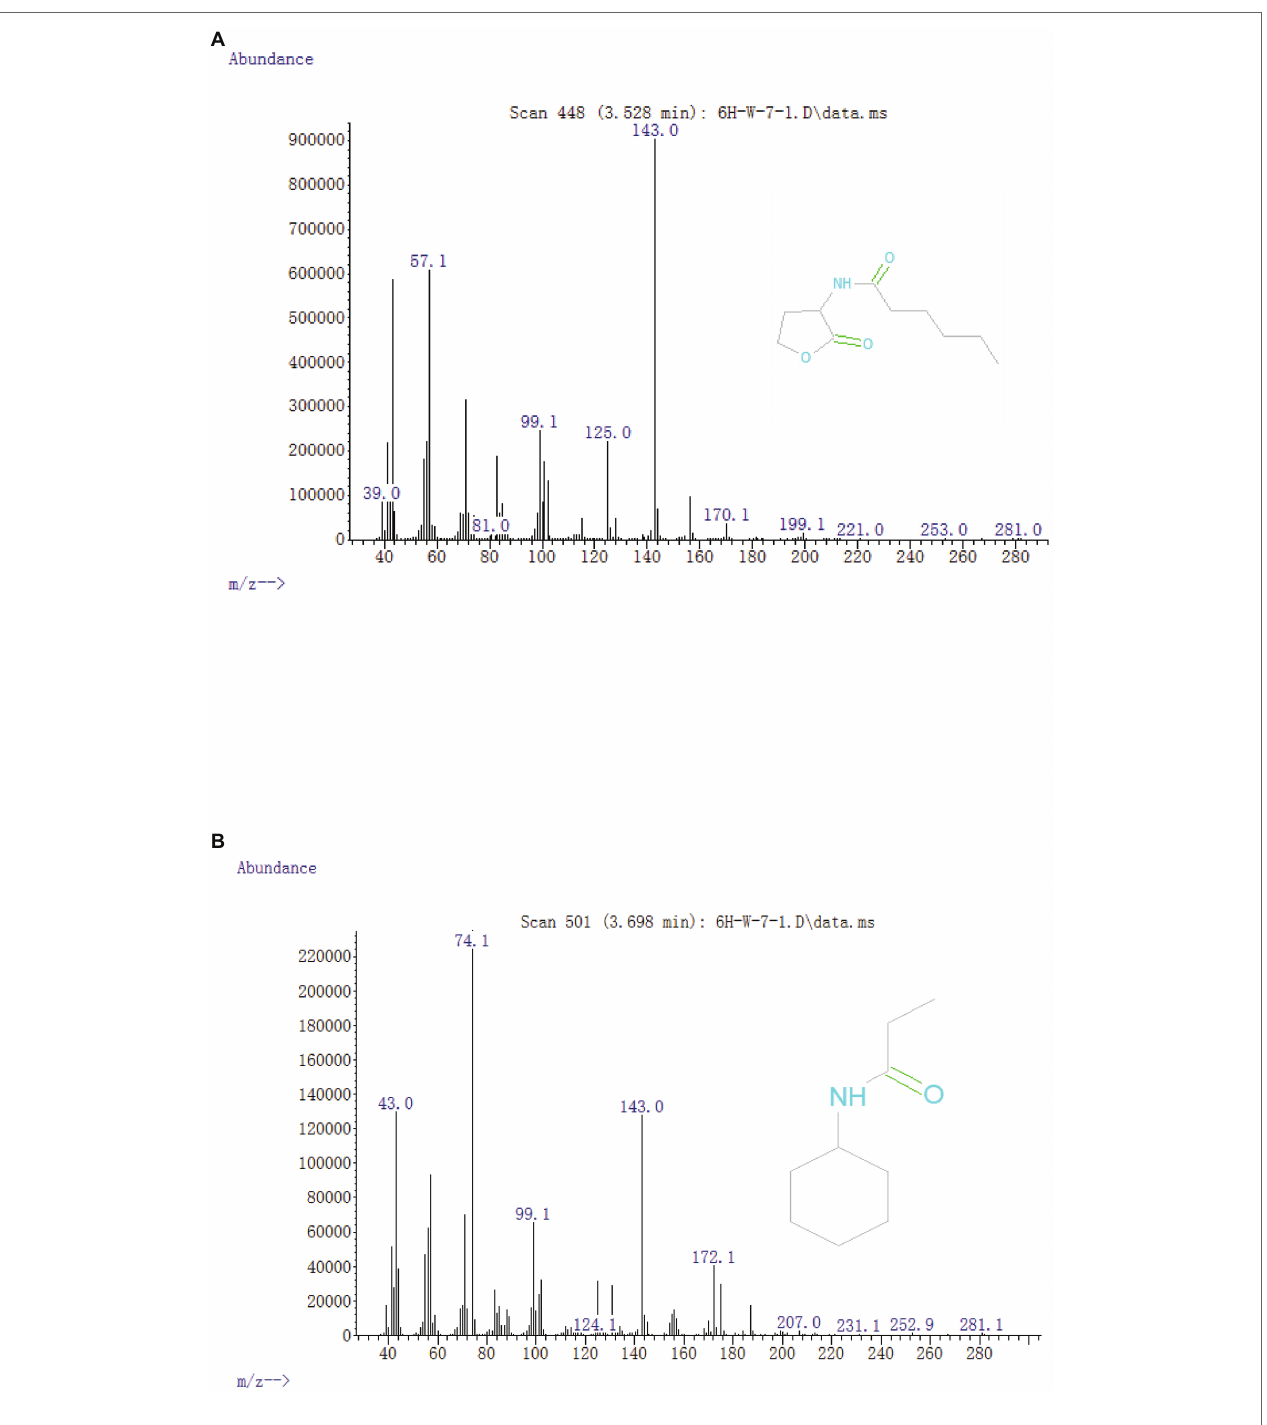
FIGURE 5 | Mass spectra of AHL degradation products produced by strain W-7. (A) HHL; (B) N